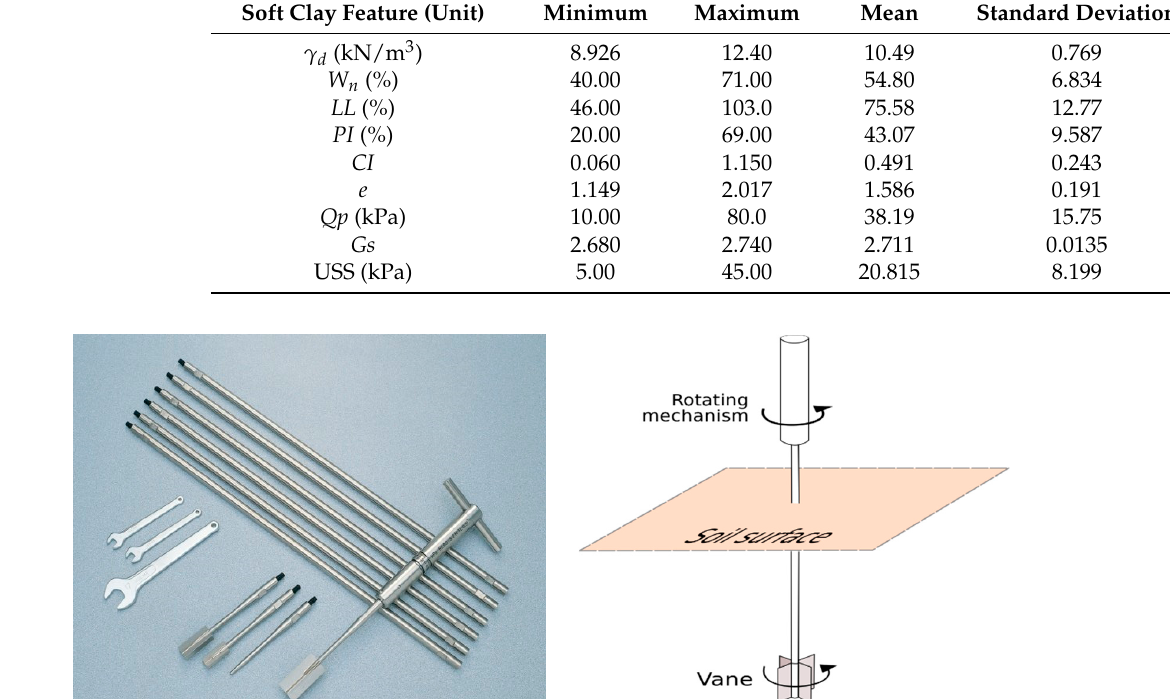
Figure 3. Sensitivity of the soft soil. In this study, we considered eight input features to create an ML predictive modeling of the soft clay soil. The datasets were initially preprocessed to eliminate any outliers that were commonly observed in realistic datasets. To eliminate the impact of incompatible data scales on model training time, and therefore make the computations much faster, the data was normalized using the following equation: 𝑥 (cid:3041) =